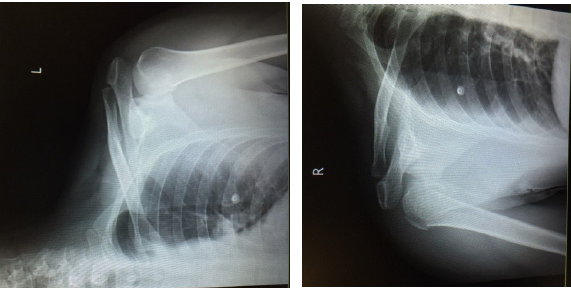
Figure 2. The comminuted neck and right arm fractures with the movement of broken bones and slightly posterior movement, and humeral epiphyseal fracture of the left arm with slight movement and lack of dislocation.